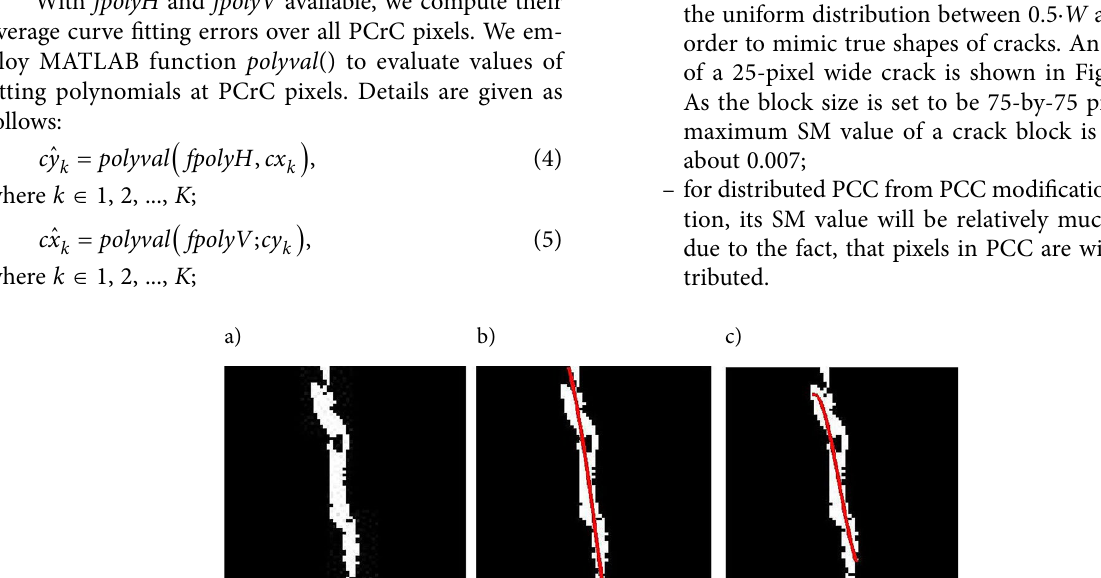
Figure 10. Example of polynomial fitting of crack pixels: a – MaxBlock ( i ) ; b – vertical curve fitting; c – horizontal curve